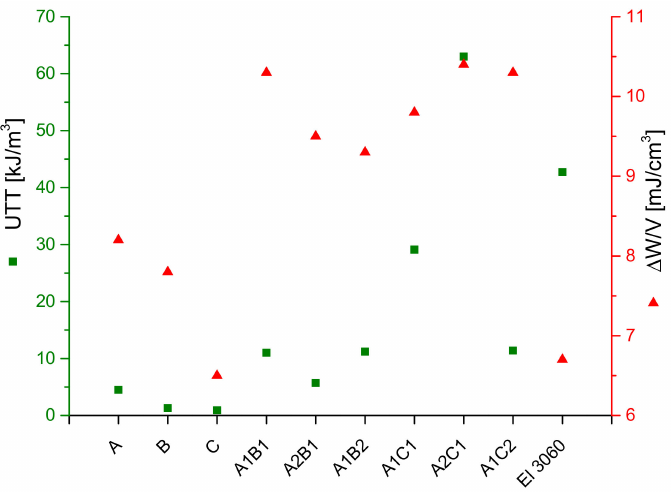
Figure 12. Toughness and energy output of the prepared